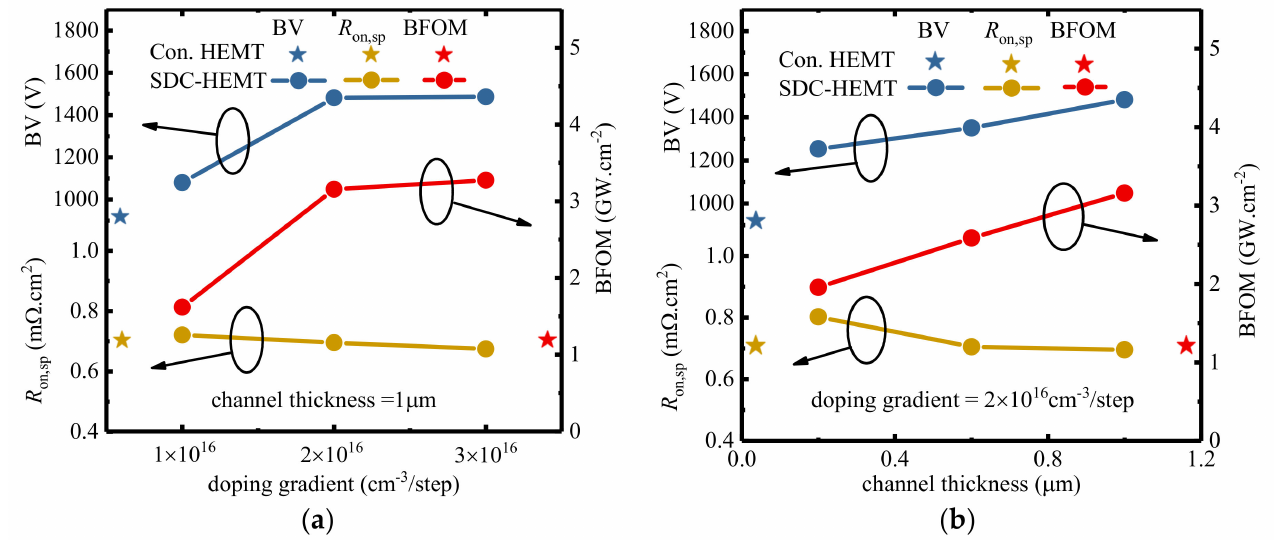
Figure 4. The BV, R on,sp , and BFOM of the SDC–HEMTs with ( a ) various doping gradients and ( b ) various channel